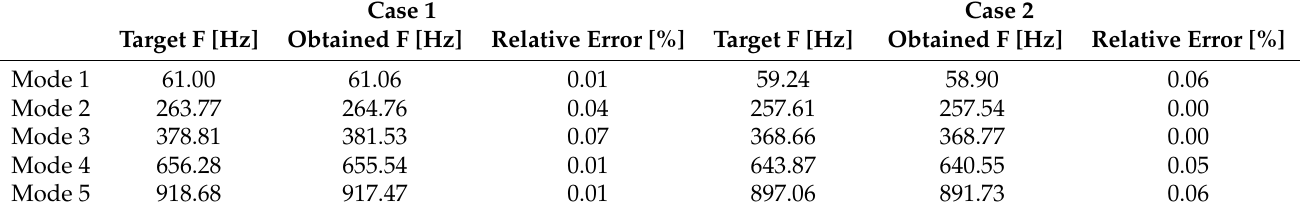
Table 2. Comparison between the target frequencies and obtained ones for Cases 1 and 2. F denotes frequency.